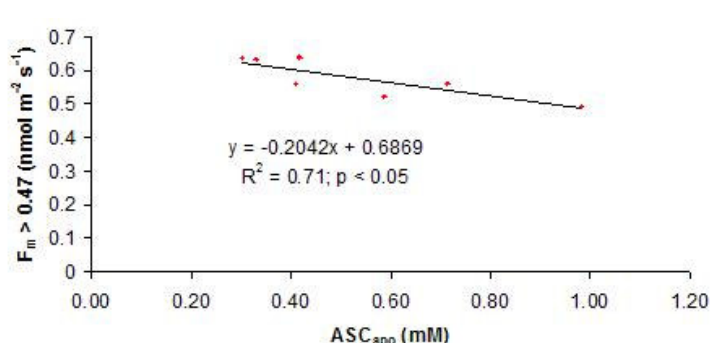
FIGURE 8. Regression for ozone flux to the plasmalemma (F m ) higher than 0.47 nmol m –2 s –1 and reduced apoplastic ascorbic acid (ASC apo ). n =